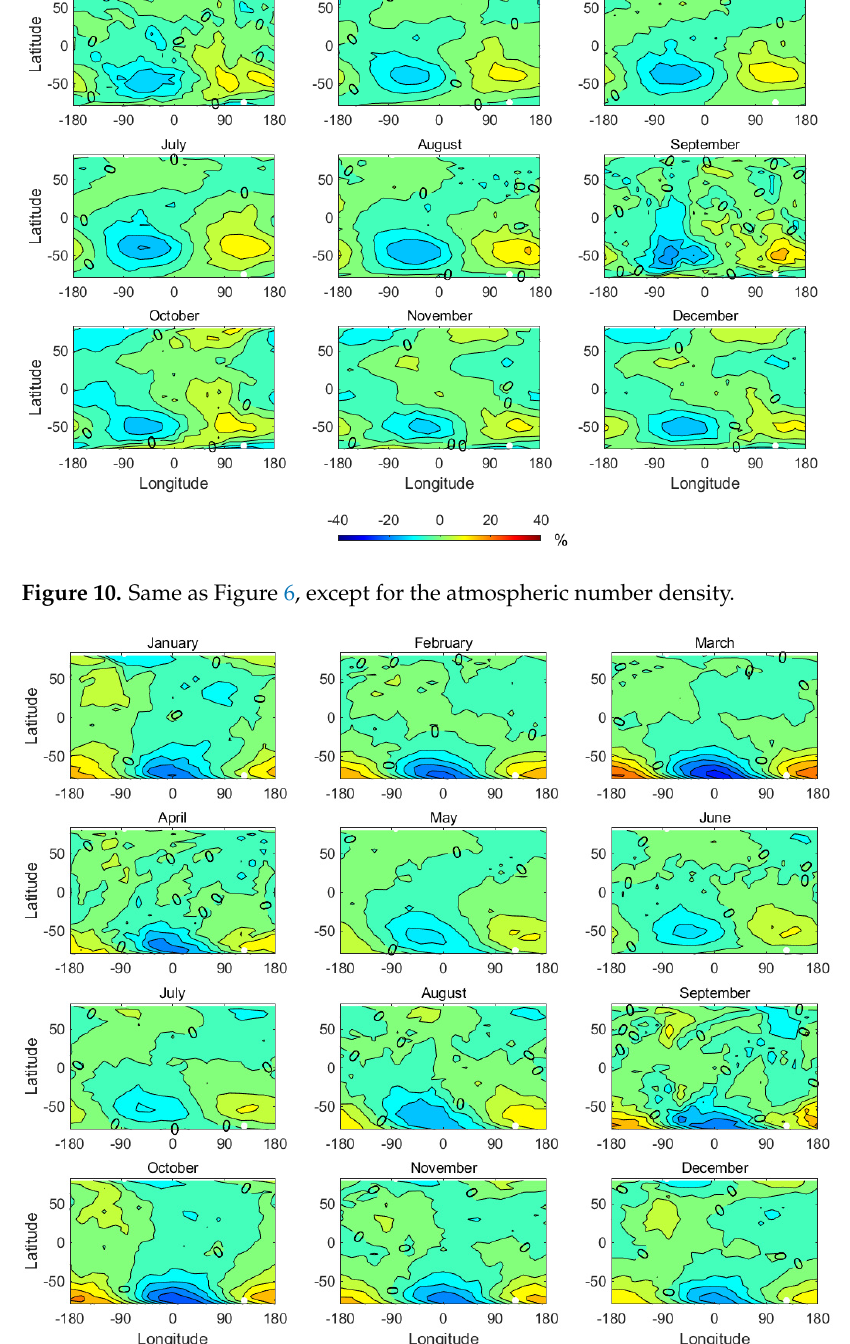
Figure 11. Same as Figure 7, except for the atmospheric number density.